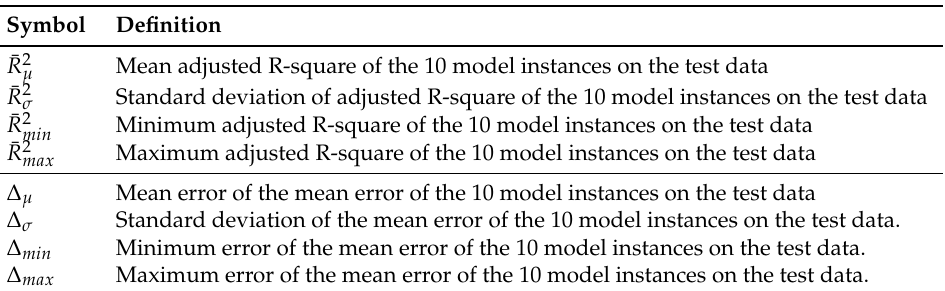
Table 7. The adjusted- R 2 and error metric variants that are used to evaluate the performance of the aggregated model